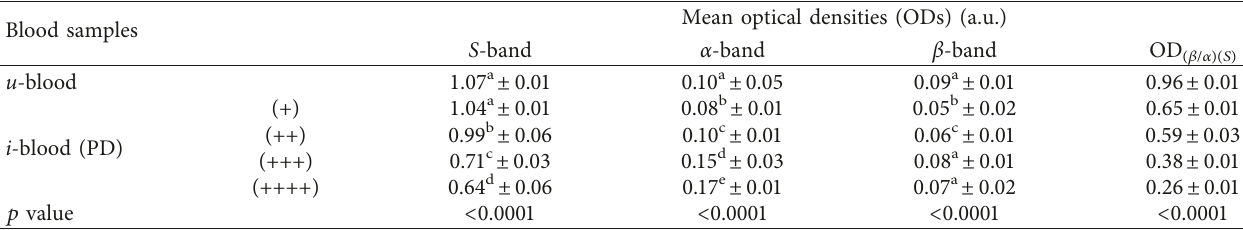
Table 1: Optical densities of uninfected and Plasmodium falciparum -infected blood samples of different parasite density at S -band, β -band, and α -band.